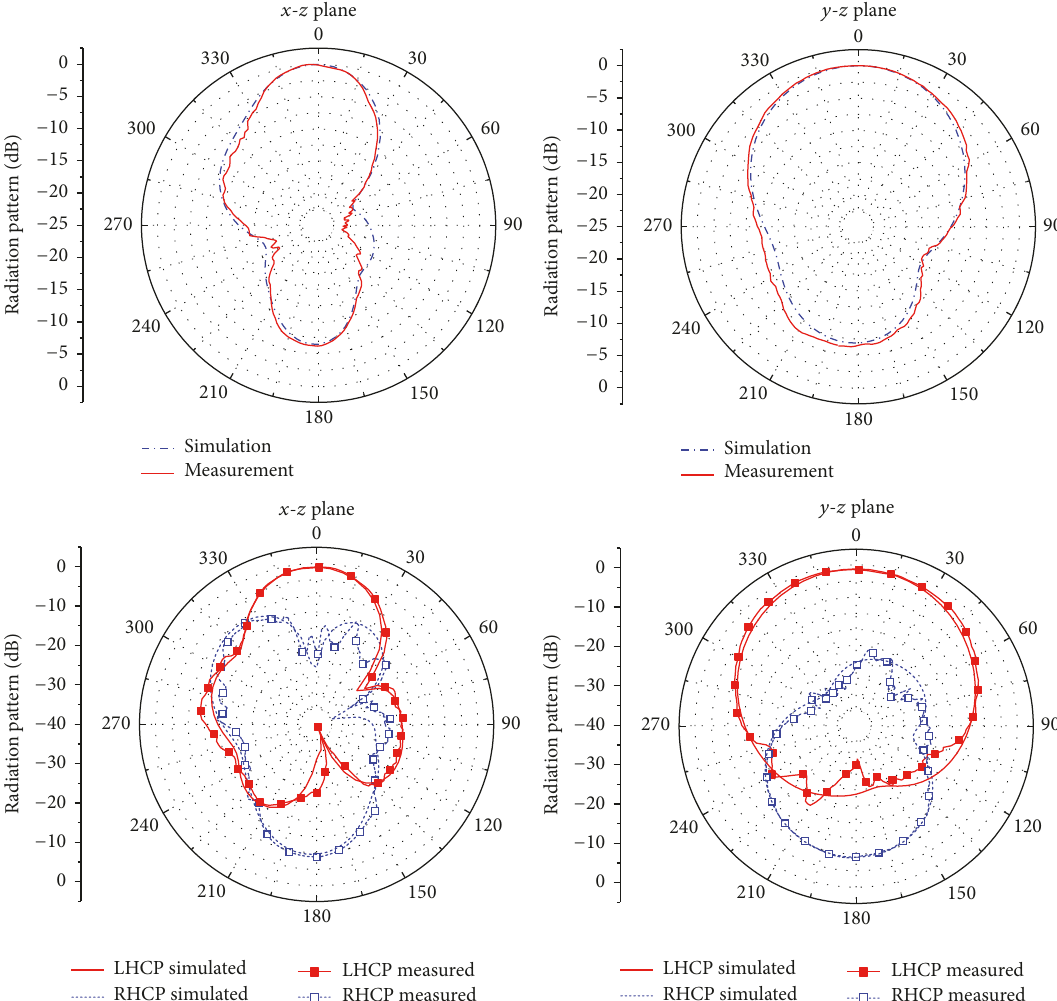
Figure 12: Measured and simulated radiation patterns and the copolar and cross-polar components of the 1 × 2